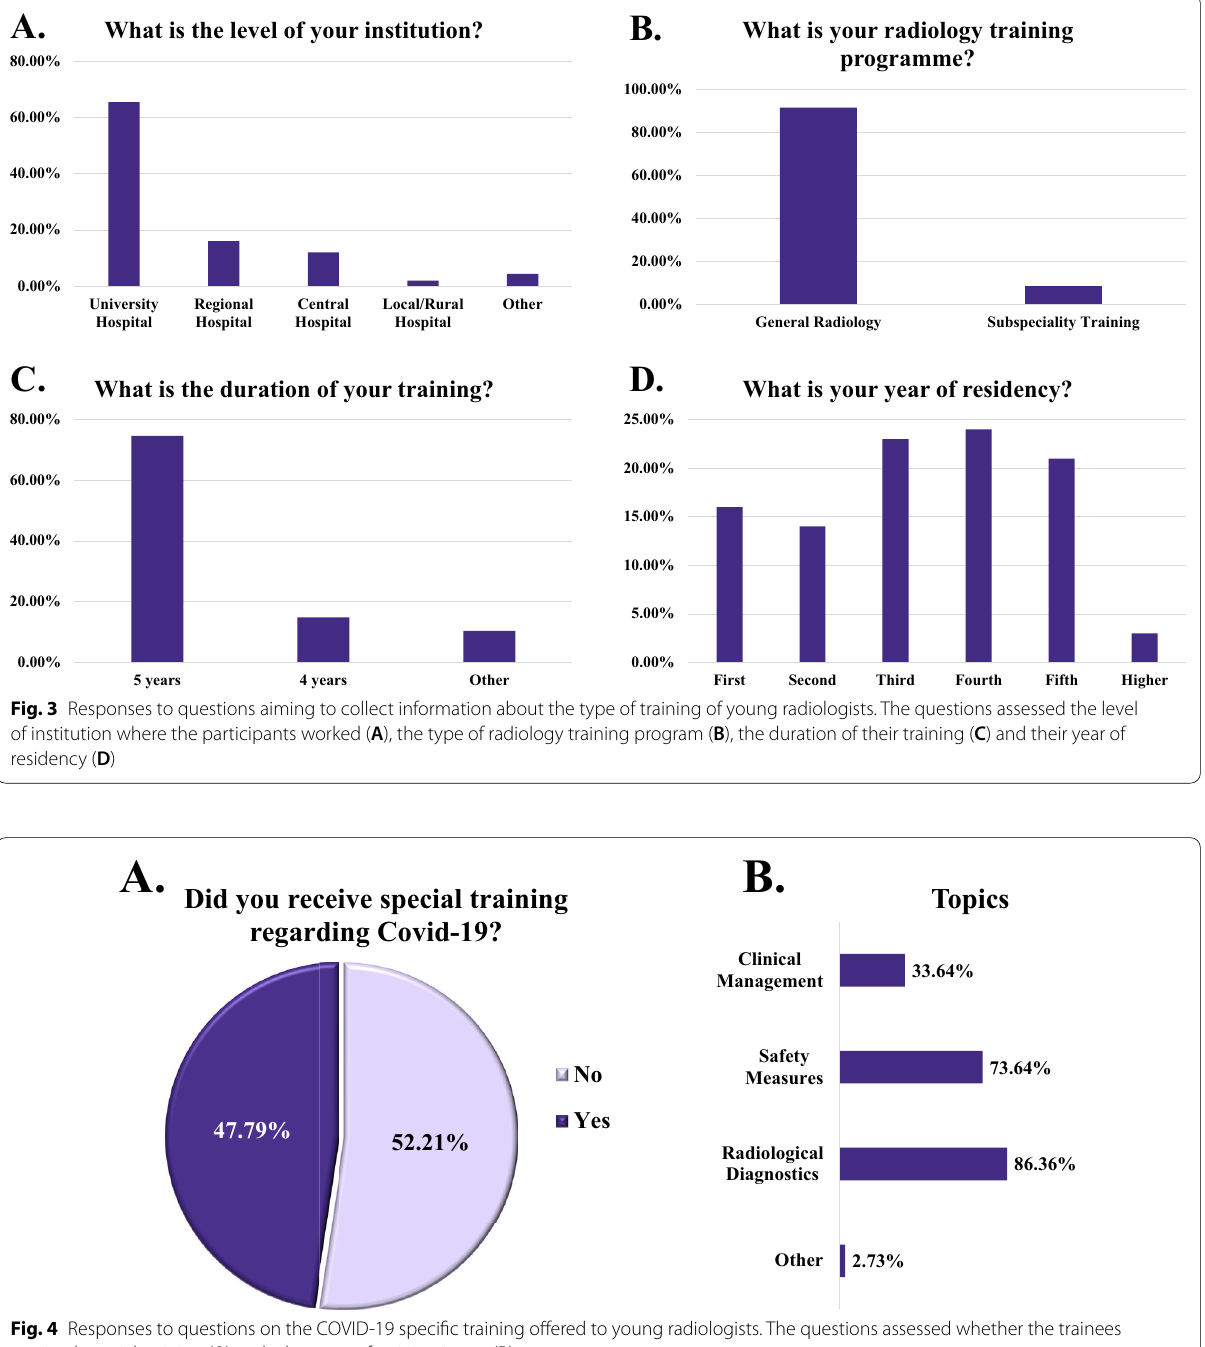
Fig. 4 Responses to questions on the COVID-19 specific training offered to young radiologists. The questions assessed whether the trainees received special training ( A ) and what type of training it was ( B